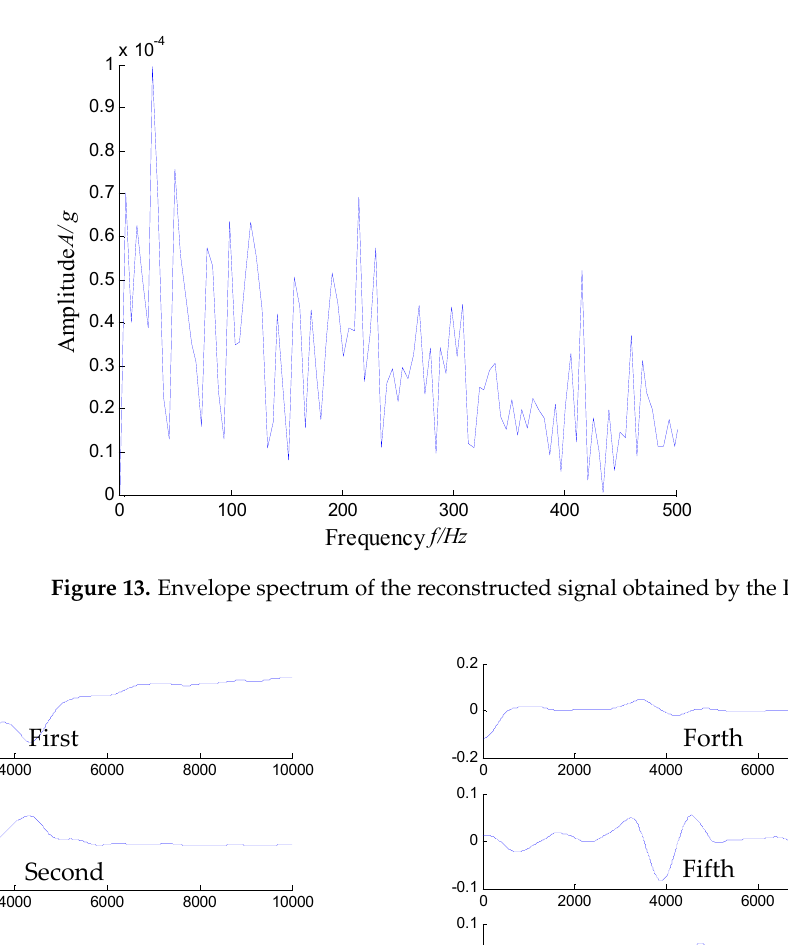
Figure 12. Waveform and spectrum of the 4th subspace obtained by the RSVD method: ( a ) waveform of the reconstructed signal and ( b ) spectrum of the reconstructed signal.